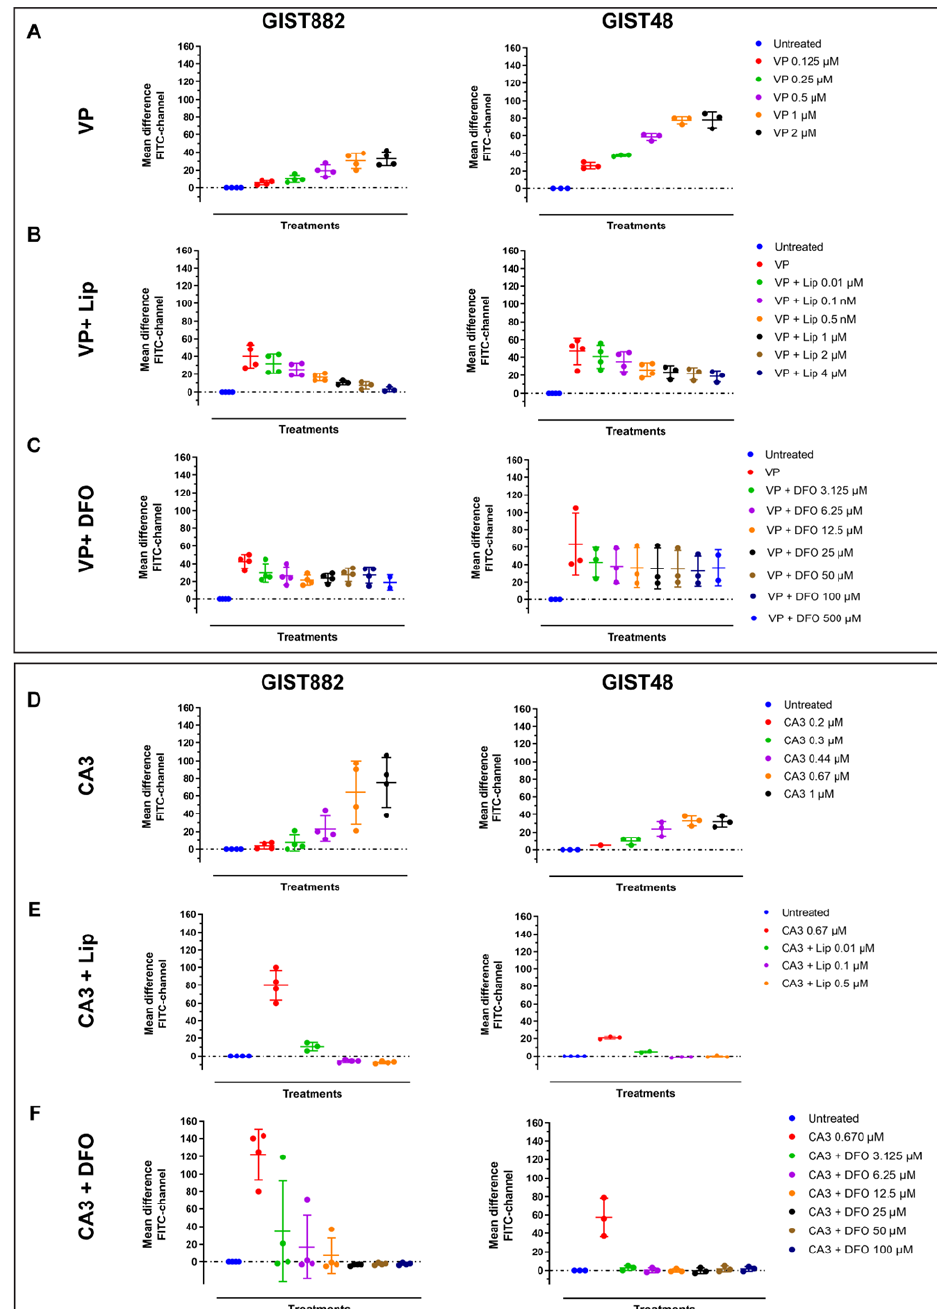
Figure 5. VP and CA3 trigger lipid peroxidation in GIST882 and GIST48 cell lines. Lipid peroxidation was assessed by flow cytometry. GIST882 and GIST48 cells are shown in the left and right panels, respectively. Upper panels: ( A ) GIST882 and GIST48 cells were treated with different concentrations of VP for 24 h. ( B ) Different concentrations of Lip were added to 2 µ M of VP in GIST882 cells or 0.5 µ M of VP in GIST48 cells. ( C ) Different concentrations of DFO were added to 2 µ M of VP in GIST882 cells or 0.5 µ M of VP in GIST48 cells. Lower panels: ( D ) GIST882 and GIST48 cells were treated with different concentrations of CA3. ( E ) Different concentrations of Lip were added to 670 nM of CA3 in GIST882 and GIST48 cells. ( F ) Different concentrations of DFO were added to 670 nM of CA3 in GIST882 and GIST48 cells. Data were analyzed with DABEST software and scatter plots were generated using Prism 9 software. Data are presented as mean values ± SD. Mean values from three or four independent